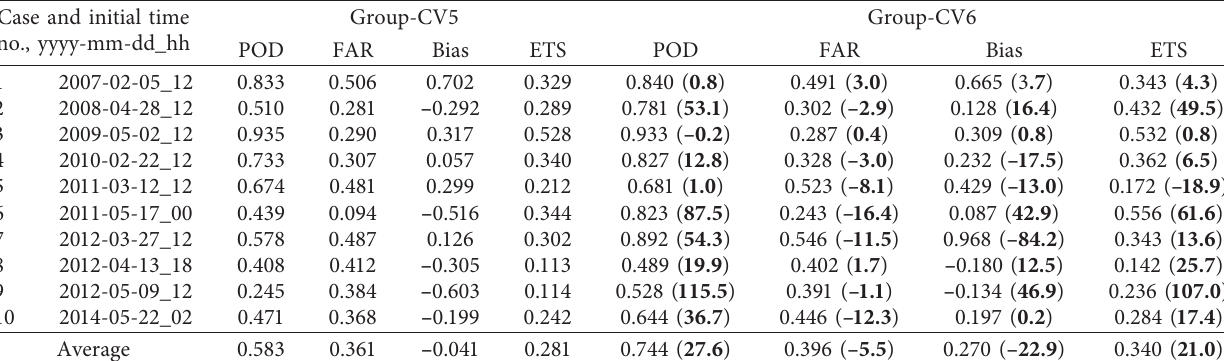
Figure 18: Boundaries of the forecasted sea fog area for Exp-B_CV5 (red lines) and Exp-B_CV5e (blue lines) (upper row) and for Exp- B_CV6 (red lines) and Exp-B_CV6e (blue lines) (lower row). The number in each panel is the enlargement rate (%) of sea fog area produced by Exp-B_CV#e compared to that by Table 3: Statistical verification result of the experiments of the 10 sea fog cases. The improvements (%) in Group-CV6 relative to Group- CV5 are in parentheses.